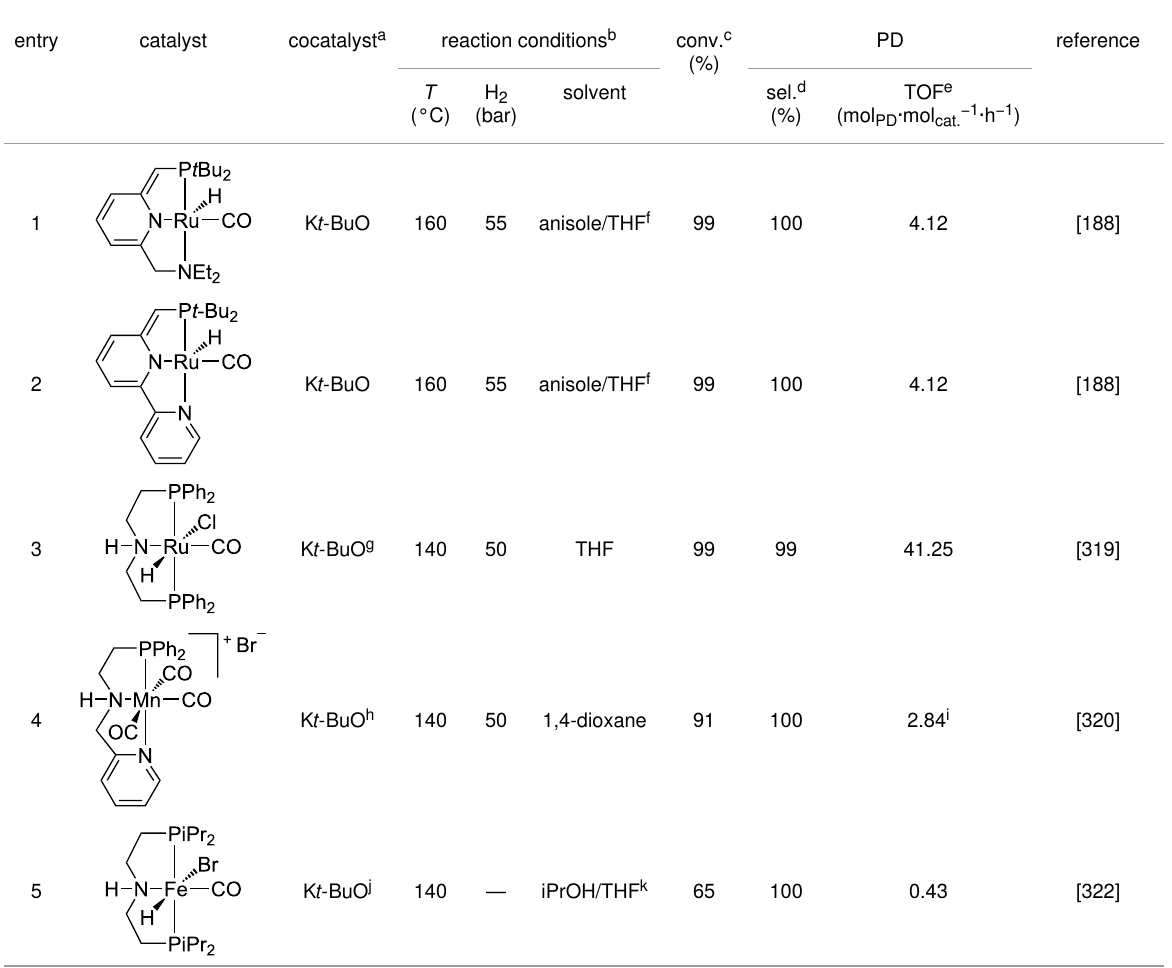
Table 6: Hydrogenolysis of PPC by molecular metal catalysts.